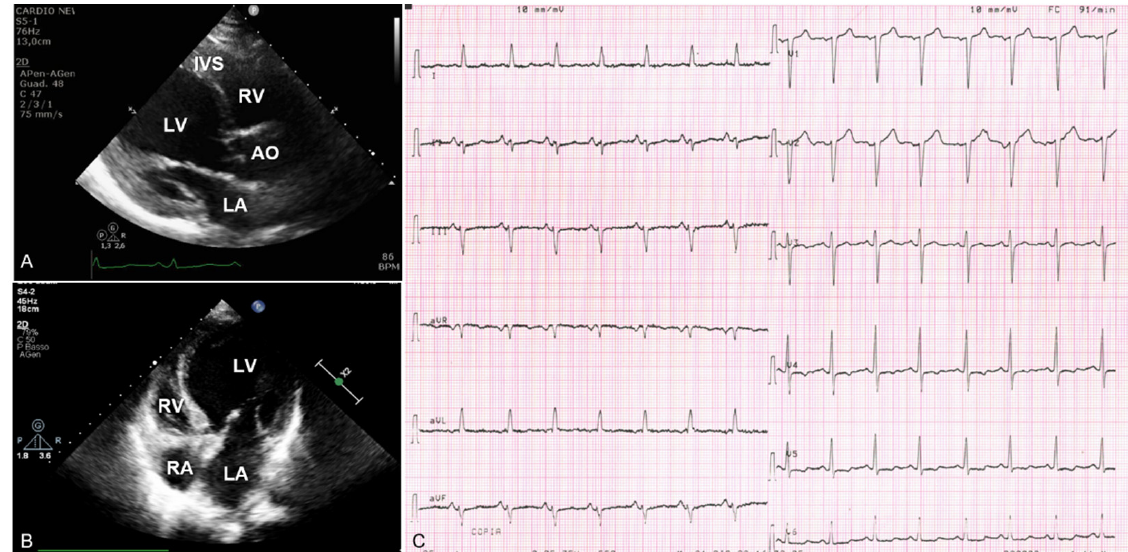
Figure 2. Echocardiographic and electrocardiographic images of the proband (III:1). ( A ) Two-dimensional transthoracic echocardiogram diastolic frames of parasternal long-axis view and ( B ) 4-chamber view showing dilated and globular-shaped left ventricle, with septal thinning. ( C ) Electrocardiogram showing left anterior hemiblock and slight ST segment depression from V4 to V6. LV—left ventricle; RV—right ventricle; LA—left atrium; RA—right atrium; AO—aorta; IVS—interventricular septum.